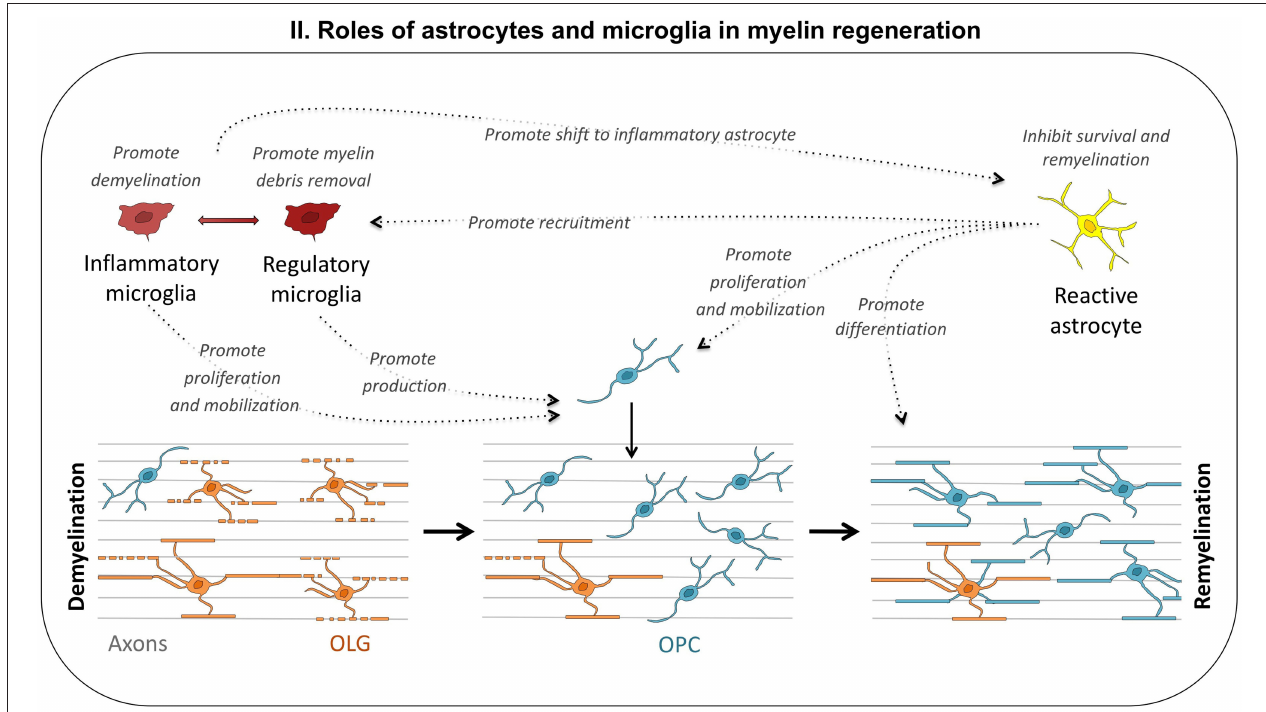
FIGURE 2 | Roles of astrocytes and microglia in myelin regeneration. Depending on environmental cues, microglial cells may adopt different phenotypes, from proinflammatory to regulatory. Inflammatory microglia promotes demyelination and astrocyte reactivity, but may also be useful to the repair process, by stimulating OPC proliferation and mobilization. Regulatory microglia promotes remyelination by enhancing debris removal and OPC production. Reactive astrocytes also play multiple roles: they inhibit remyelination through inflammatory cytokine production and ECM modifications, promote myelin debris removal by recruiting microglia, and stimulate